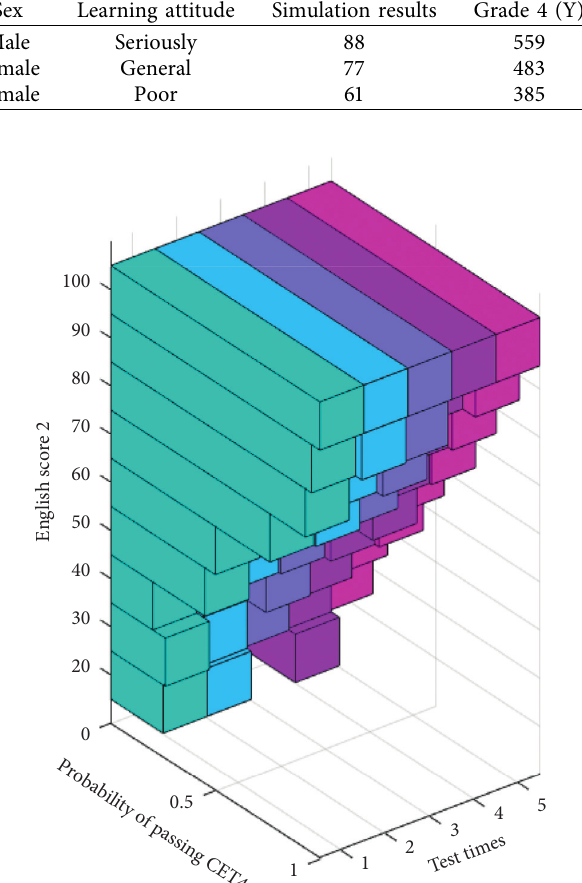
Figure 4: The relationship between CET-4 and College English